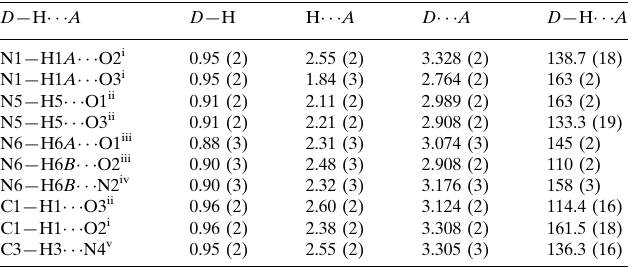
Hydrogen-bond geometry (A˚ , (cid:3)